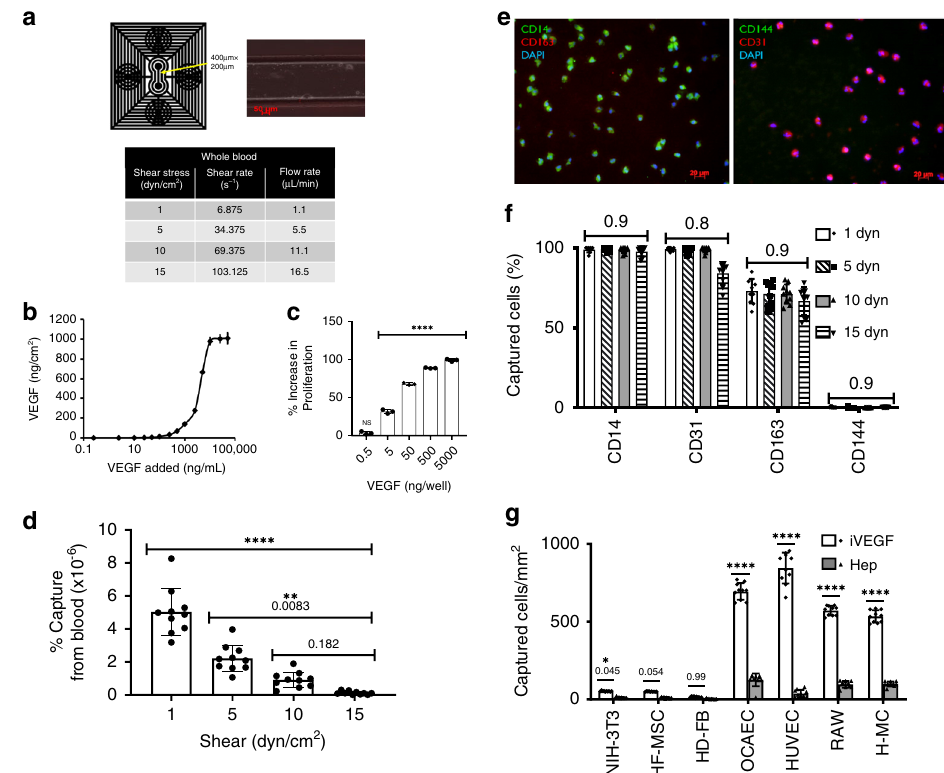
Fig. 2 VEGF Captures Monocytes Under Flow. Micro fl uidic device to capture of cells from blood: schematic and shear dependency. a Schematic of micro fl uidic device. PDMS device is sealed to iVEGF using a vacuum. An empty channel image is shown. b VEGF binding kinetics to CH surface as determined by ELISA, n = 3 independent biological replicates; error bars denote ± SD of the mean. c MTT proliferation of HUVECs on iVEGF with a range of initial soluble VEGF concentrations added per well; n = 3 independent biological replicates; Four asterisk indicates statistical difference ( p < 0.0001) compared to control (no VEGF) using one-way ANOVA and Dunnett ’ s test (DF = 12, F = 2101); error bars denote ±SD of the mean. d – f Whole human blood was passed through the micro fl uidic device on iVEGF at the indicated shear stress. All runs were 1 mL of blood. Total captured cells ( d ) were analyzed as captured cells per total cell count of 1 mL of blood, n = 10 independent biological replicates per shear strength; four asterisk indicates statistical difference ( p < 0.0001), p -values as indicated determined by one-way ANOVA and Tukey ’ s test (DF = 36; F = 63.78); error bars denote ±SD of the mean. e , f Immunostaining with antibodies against MC markers CD14, CD163, and CD31 and EC marker CD144. e Representative imag e s at 1 dyn/cm 2 are shown. Images were quanti fi ed ( f ) as shown over the 10 independent biological replicates per shear (1 dyn; white bars, 5 dyn; diagonal thatched bars, 10 dyn; gray bars, 15 dyn horizontal thatched bars). No signi fi cant difference ( p values indicated) between shear strengths and identity using two-way ANOVA and Sidak ’ s test; error bars denote ±SD of the mean. EC markers are observed in <1% of total cells under all shears tested. g VEGF captures cells expressing the VEGF receptors with high speci fi city, n = 10 independent biological runs per cell type (NIH-3T3; mouse fi broblast line, HF-MSC human hair follicle-derived mesenchymal stem cells, HD-FB human dermal fi broblasts, HUVEC human umbilical vein endothelial cell, OCAEC ovine carotid artery endothelial cell, RAW mouse macrophage line, H-MC human peripheral blood monocytes). Signi fi cance determined using two-way ANOVA and Sidak ’ s test (DF = 36, F = 1.458), signi fi cance as indicated; four asterisk denotes statistical difference p < 0.0001 as compared to cells captured on CH surface; error bars denote ±SD of the mean; iVEGF white bars, Hep surface gray